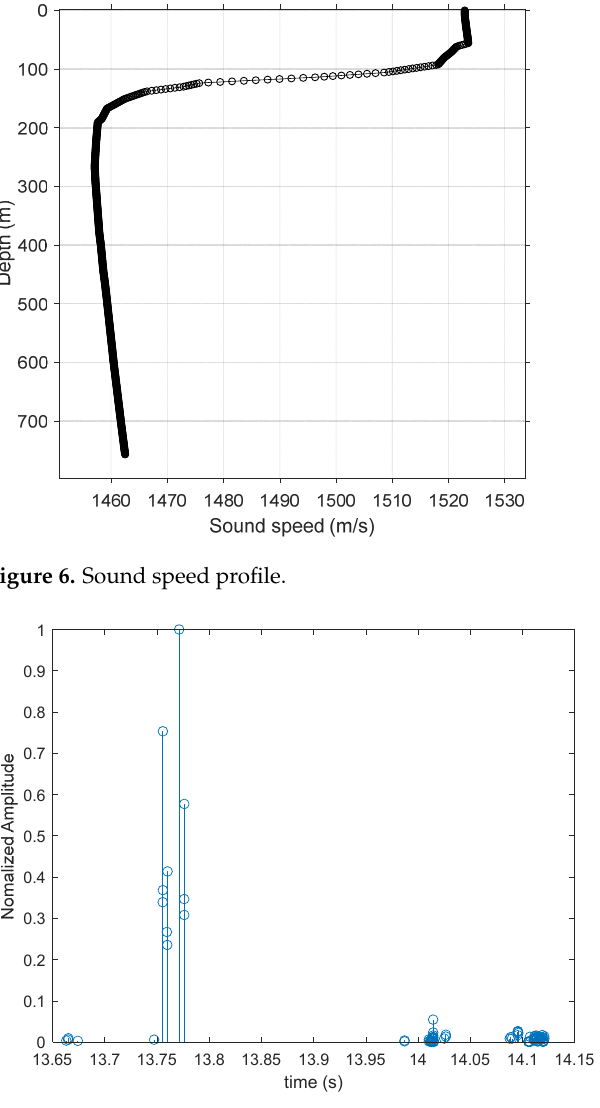
Figure 7. Channel impulse response by Bellhop model.